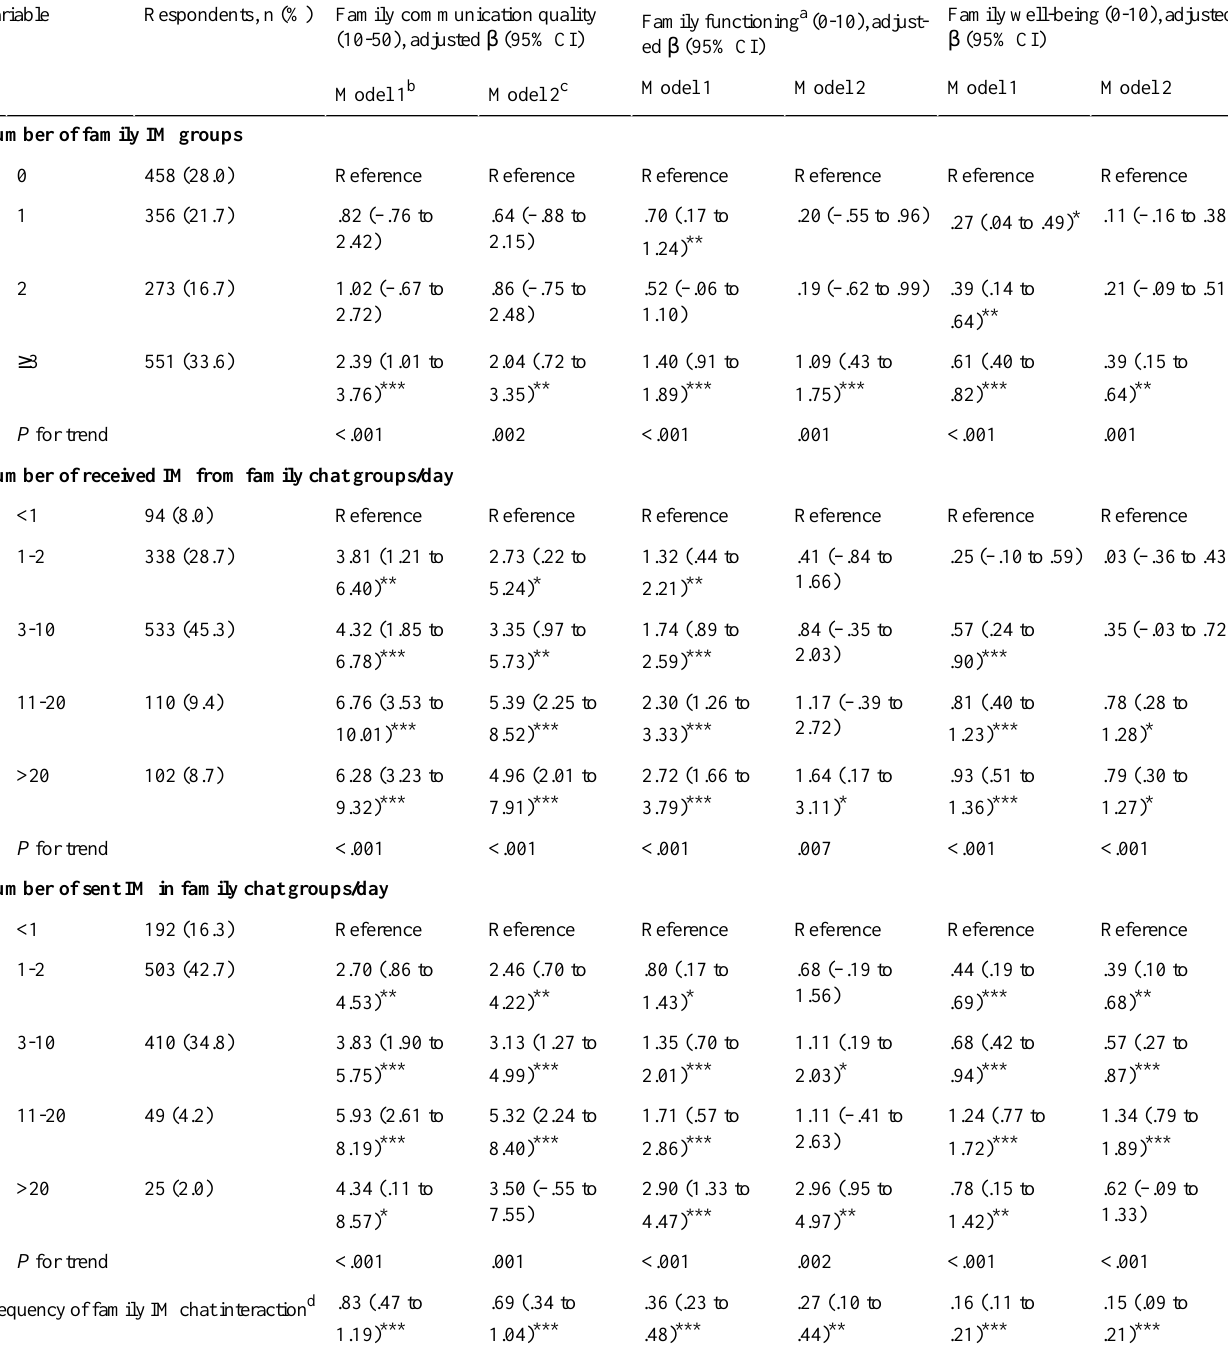
Table 2. Association of the number of family instant message (IM) chat groups (N=1638) and use (N=1180) with family communication, family functioning, and family